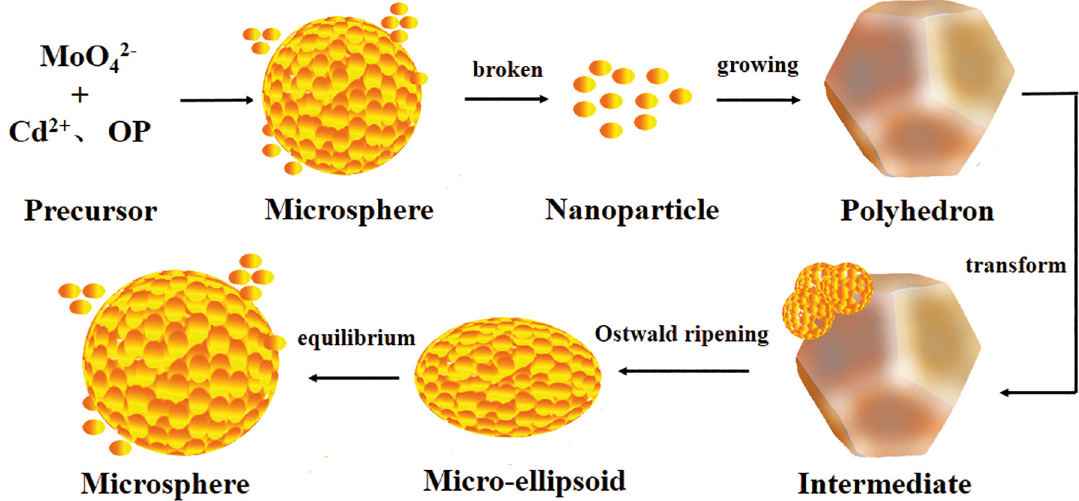
micro-ellipsoids. Figure 9: Schematic illustration of the growth process of CdMoO 4 The crystal facet and crystallinity of CdMoO play a key CdMoO micro-ellipsoids exhibit excellent photocatalytic 4 4 part in its photocatalytic activity. Moreover, the formation activity for RhB degradation. This work may demonstrate mechanism of CdMoO micro-ellipsoids was investigated, a general method for synthesizing other photocatalytic 4 which is related to an Ostwald ripening process. Notably, the materials with special